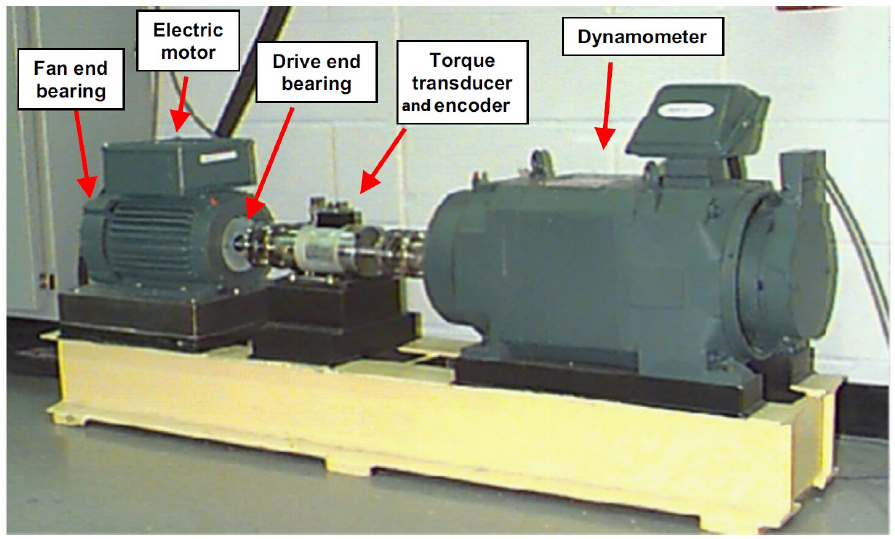
Figure 5. Bearing test rig.